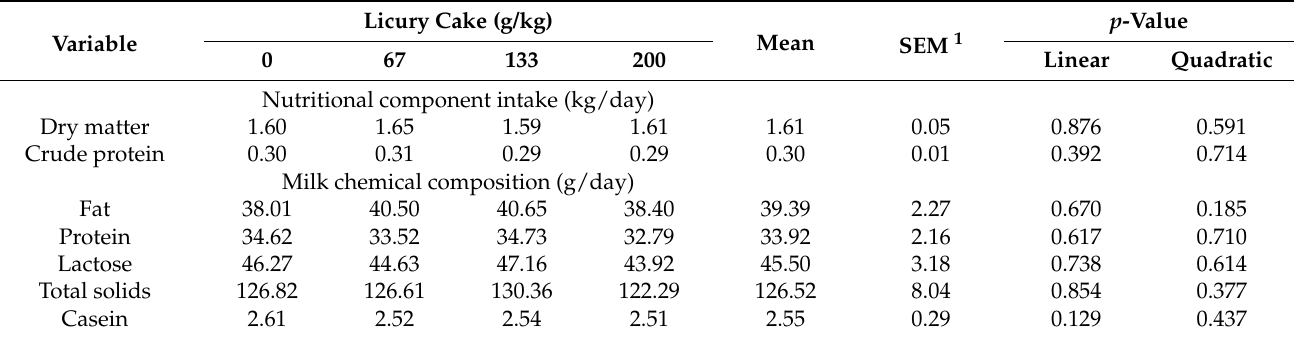
Table 2. Nutritional components’ intake and chemical composition of milk from lactating goats fed diets with increasing levels of licury